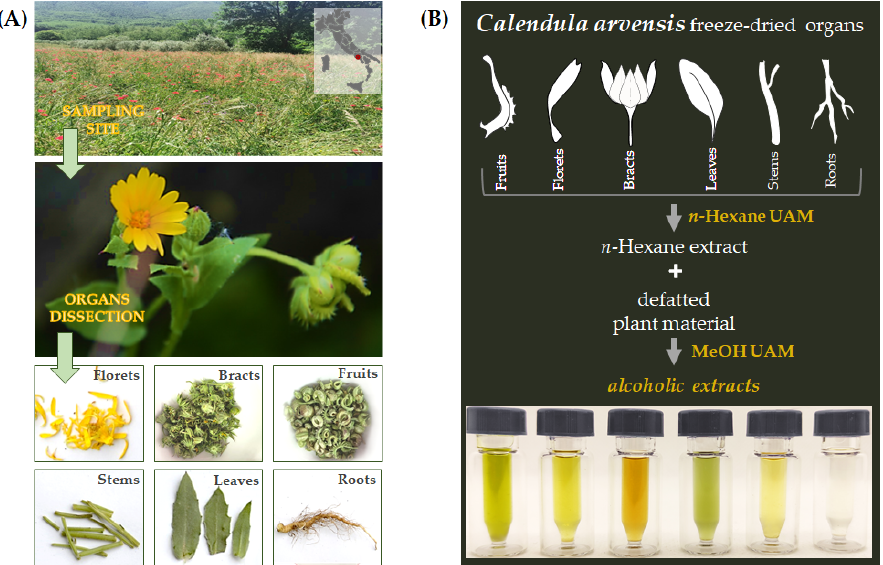
Figure 1. C. arvensis sampling site and organs separation ( A ); fractionation scheme of the plant’s freeze ‐ dried organs ( B ).